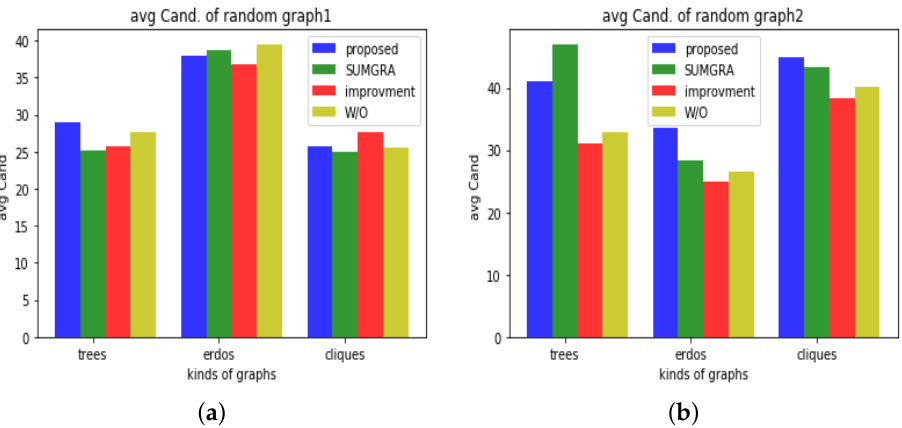
Figure 9. avg size of C uinit on ( a ) random 1 dataset, and ( b ) random 2 dataset.